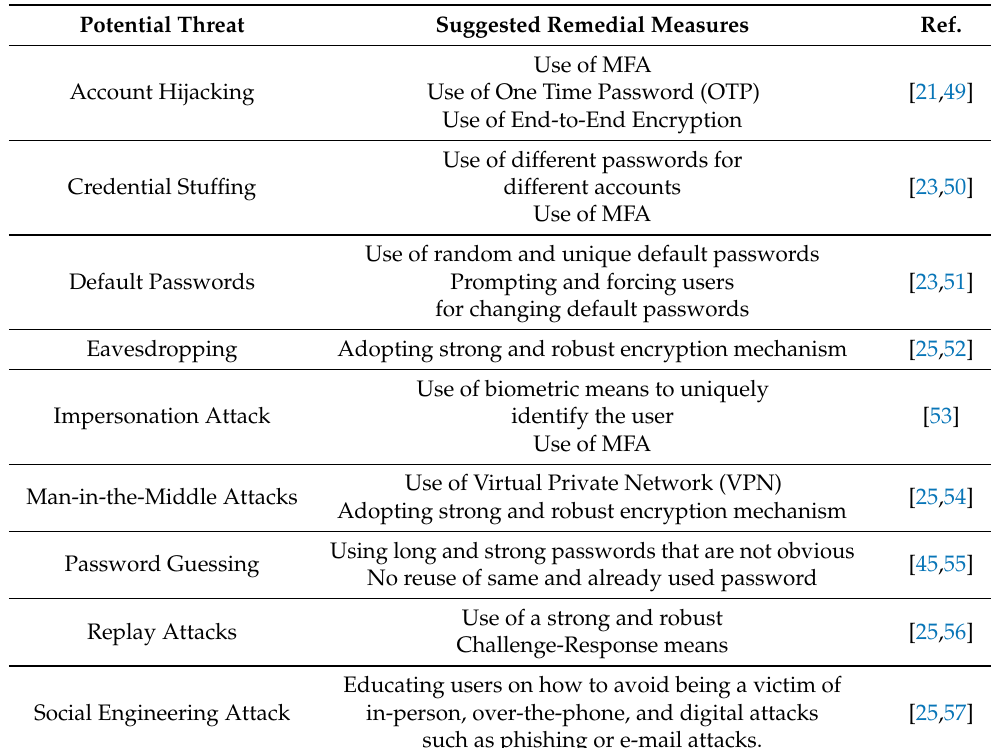
Table 1. Threats to Cloud Authentication and their Remedial